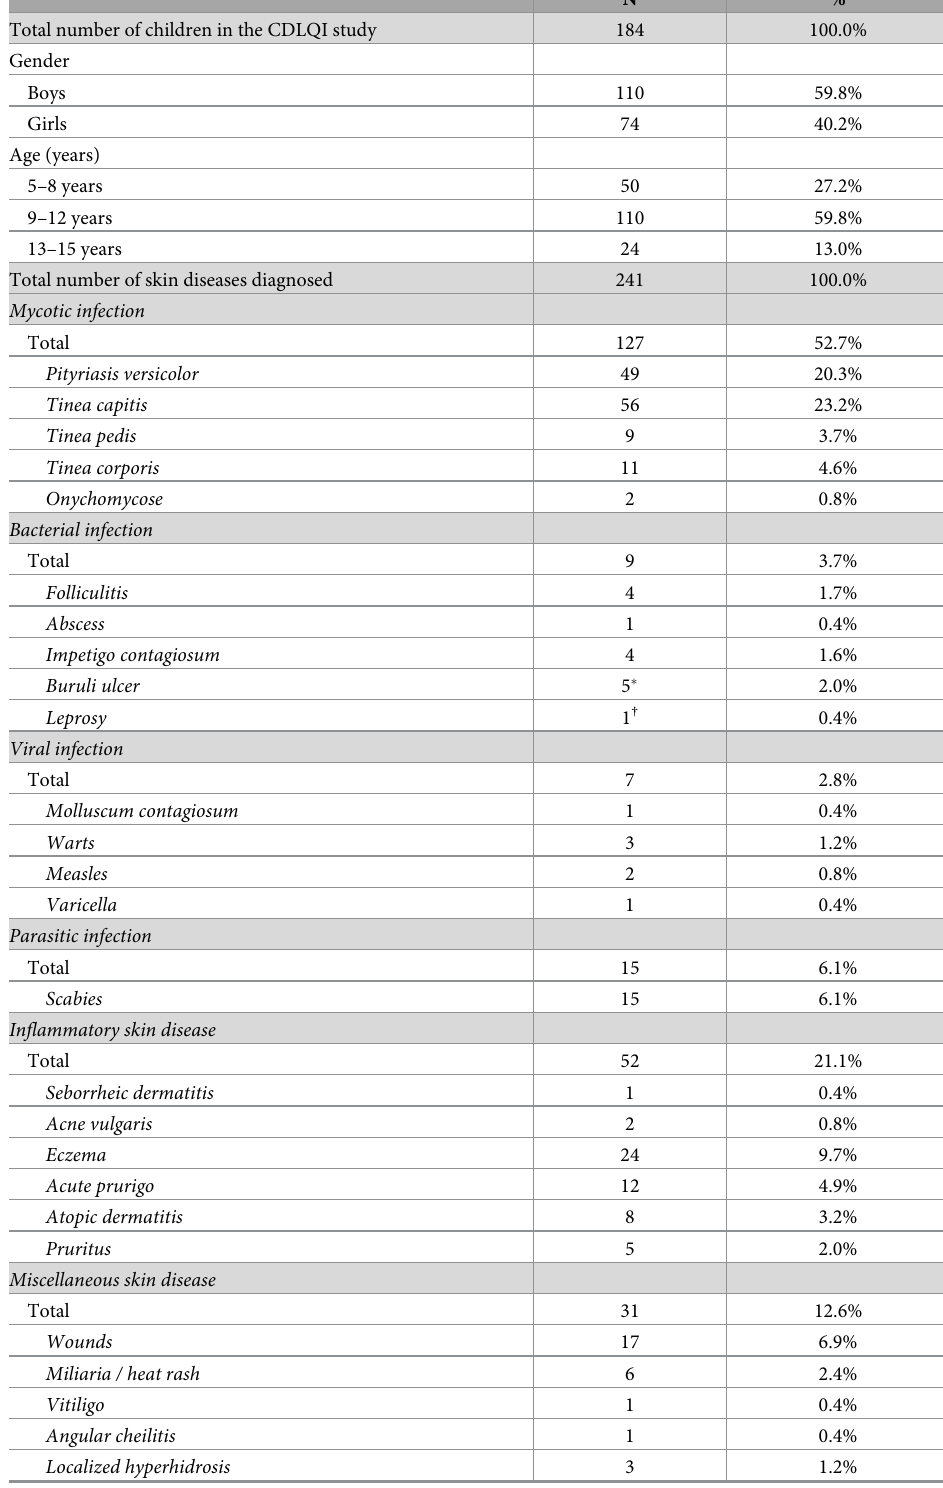
Table 1. Spectrum of skin diseases in schoolchildren in the CDLQI